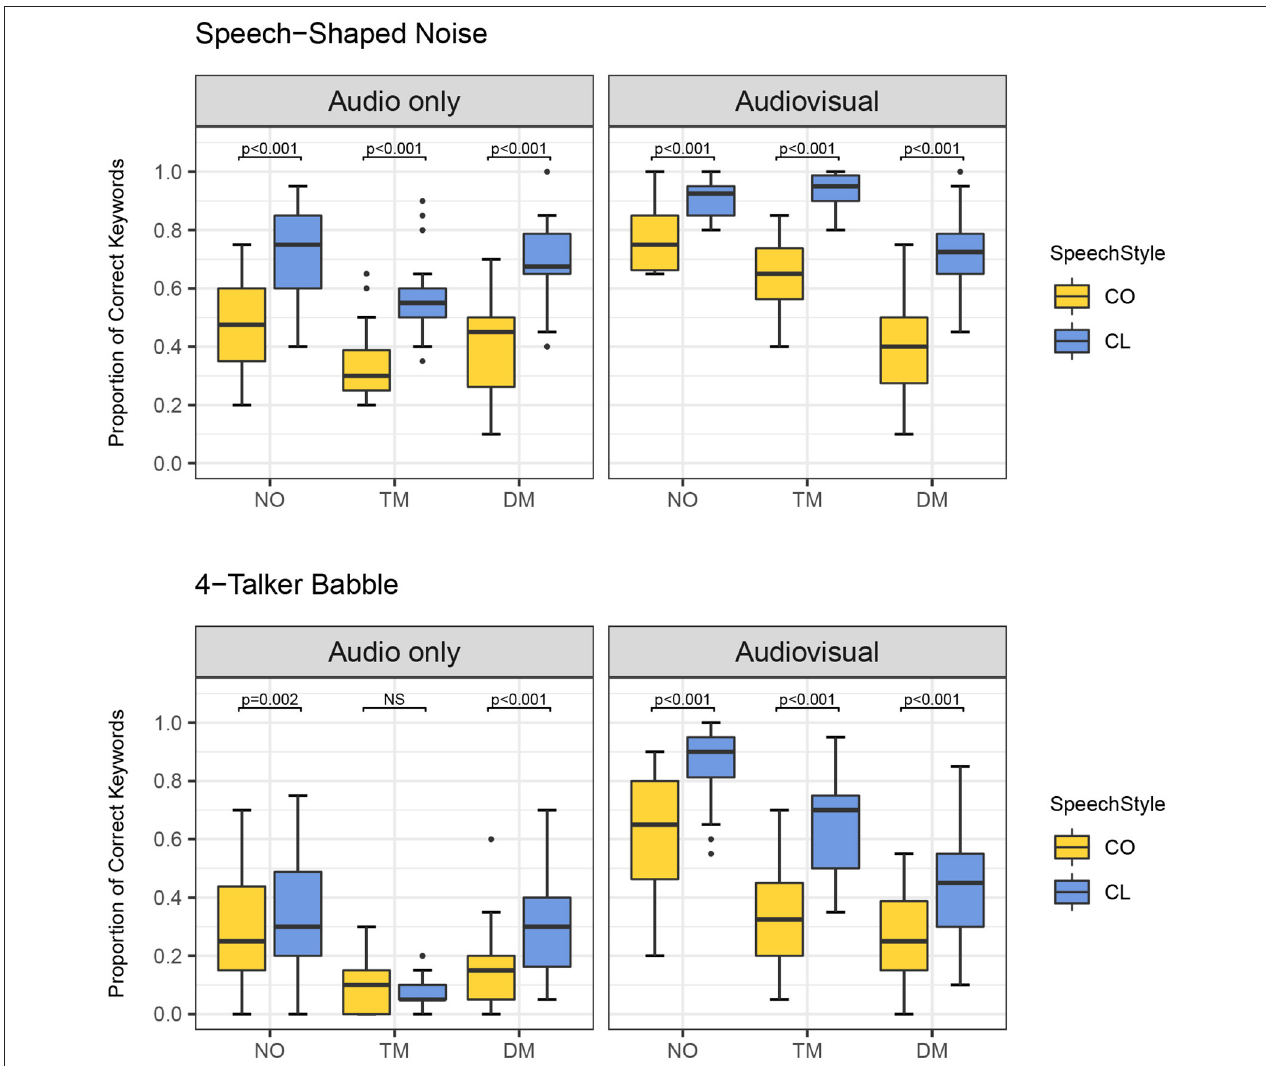
FIGURE 5 | Proportion of correct keywords in sentences for comparisons between conversational (CO) and clear (CL) in each type of face masks (no mask: NO, transparent mask: TM, disposable face mask: DM) in both background noises and presentation